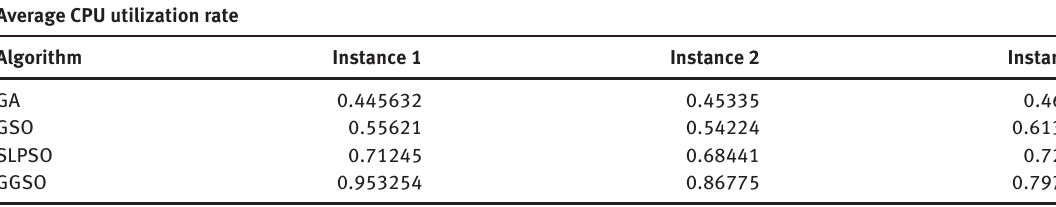
Table 14: Comparison for CPU Utilization Rate.